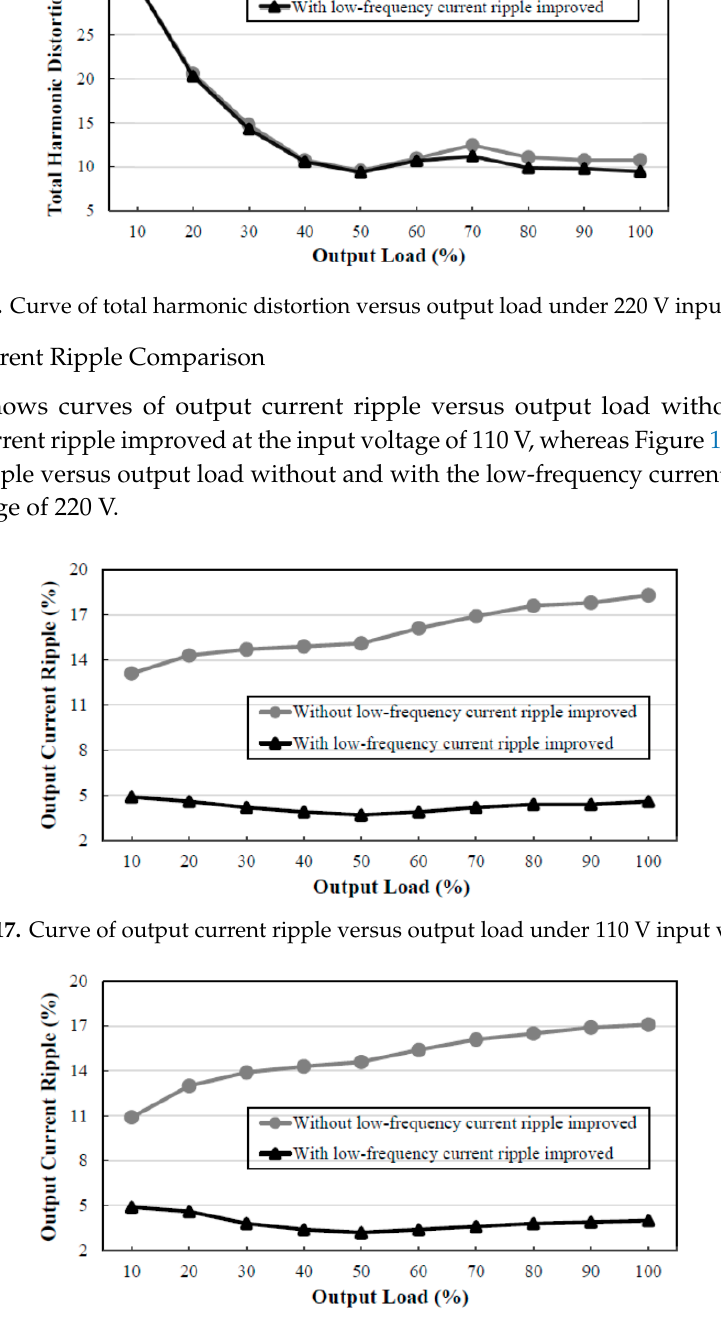
Figure 15. Curve of total harmonic distortion versus output load under 110 V input voltage.